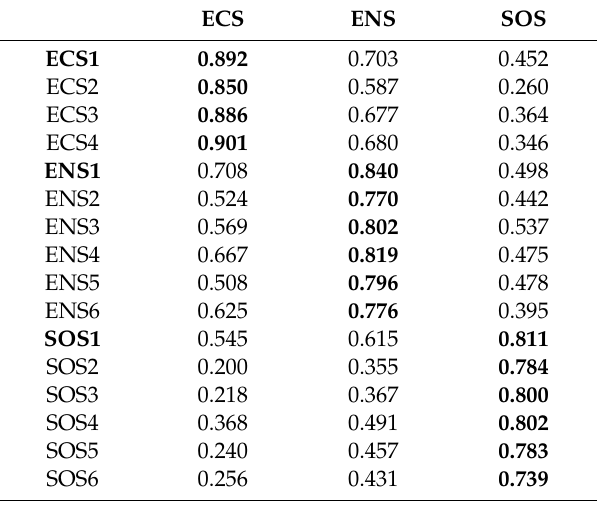
Table 5. Cross-loadings.